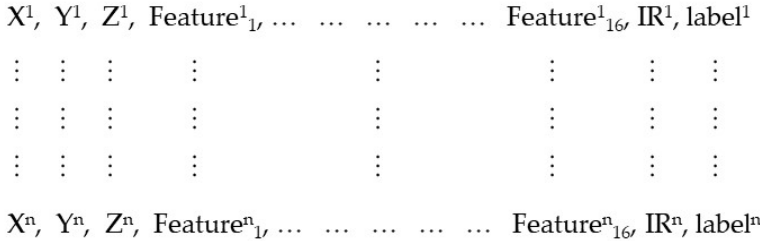
Figure 5. Structure of the dataset obtained after waveform and infrared intensities processing. The point-based classification method is described in the following paragraphs. It relied on the interpolated IR intensities and on spectral features extracted from the waveforms. green